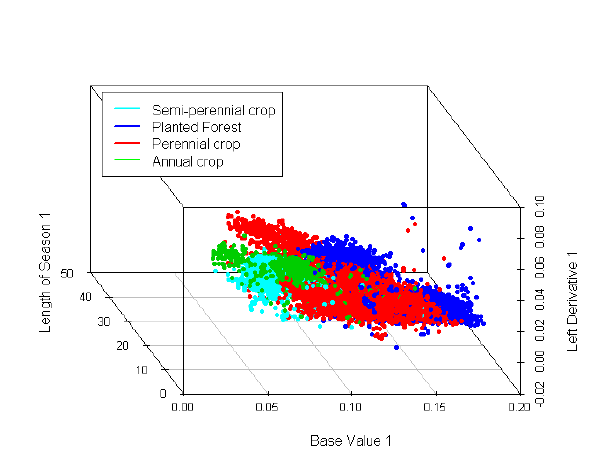
Figure 9. 3D-scatterplot of length of season, base value and left derivative features of the first seasons. The zero values was removed for best